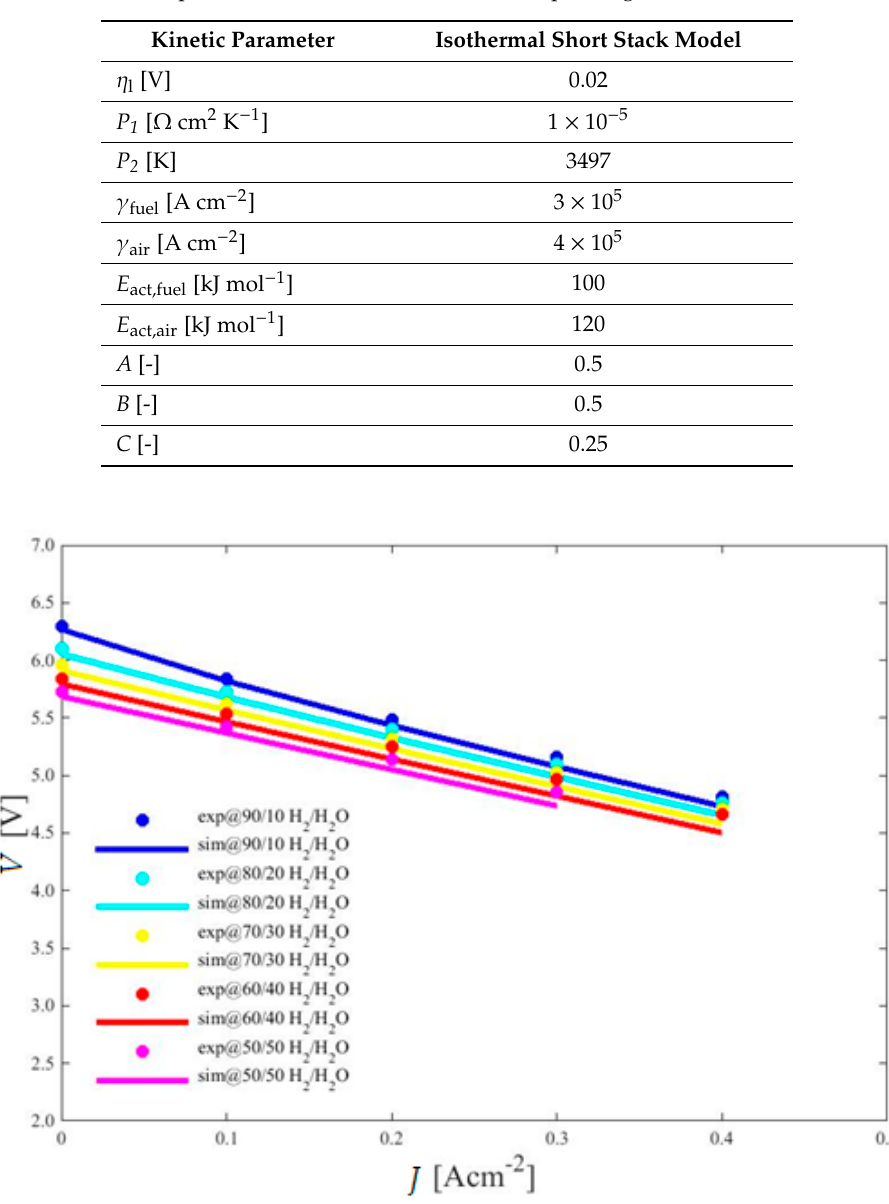
Figure 2. Polarization curves validation of a Solid Oxide Fuel Cell (SOFC) short stack working at 1023 K though 2D isothermal modeling.